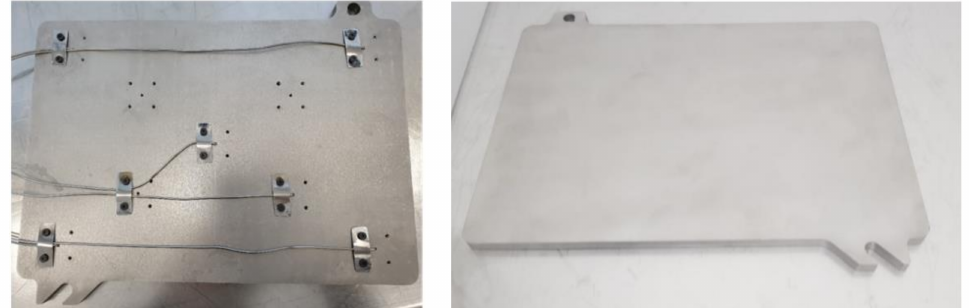
Figure 3. Stainless steel plate. On the right —the plate’s upper side (toward the electron beam). On the left —thermocouples that were inserted into bores on the lower side of the plate. In addition to those on the plate, thermocouples were also attached to the heat shield (Figure 4). The thermocouples facilitated the measurement of the heat shield tempera- ture, thus indicating whether changes in gas pressure affect the heat dissipation during the process.